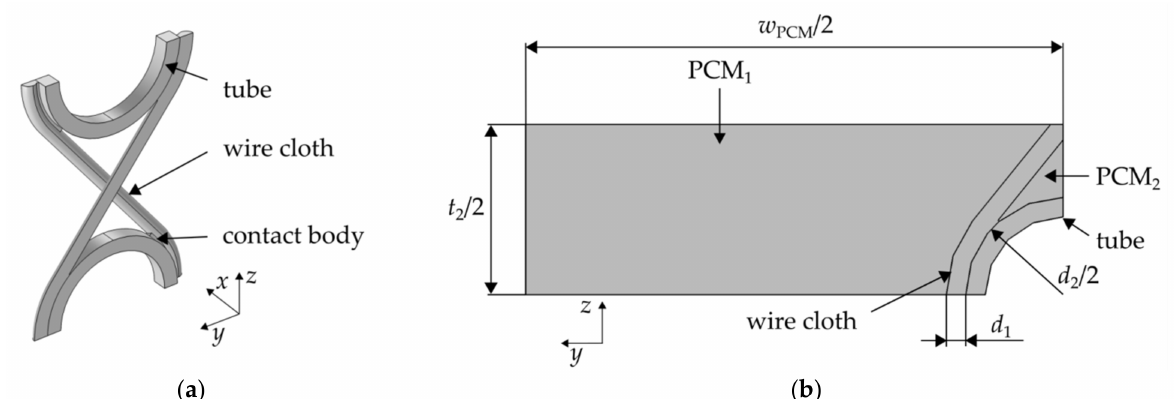
Figure 8. ( a ) Three-dimensional (3D) structure of wire cloth element; ( b ) Simplified 2D geometry of the wire cloth element with PCM. The regions PCM 1 and PCM 2 are defined for the consideration of natural convection.